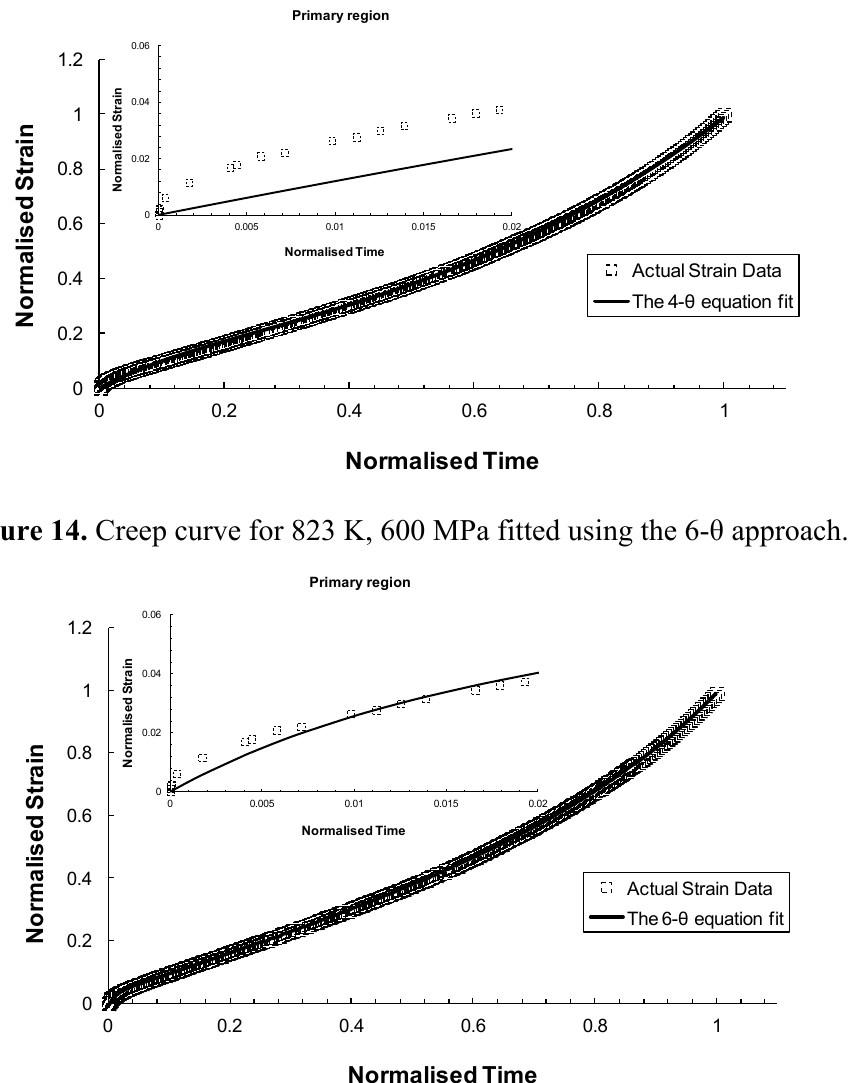
Figure 13. Creep curve for 823 K, 600 MPa fitted using the 4-θ approach.